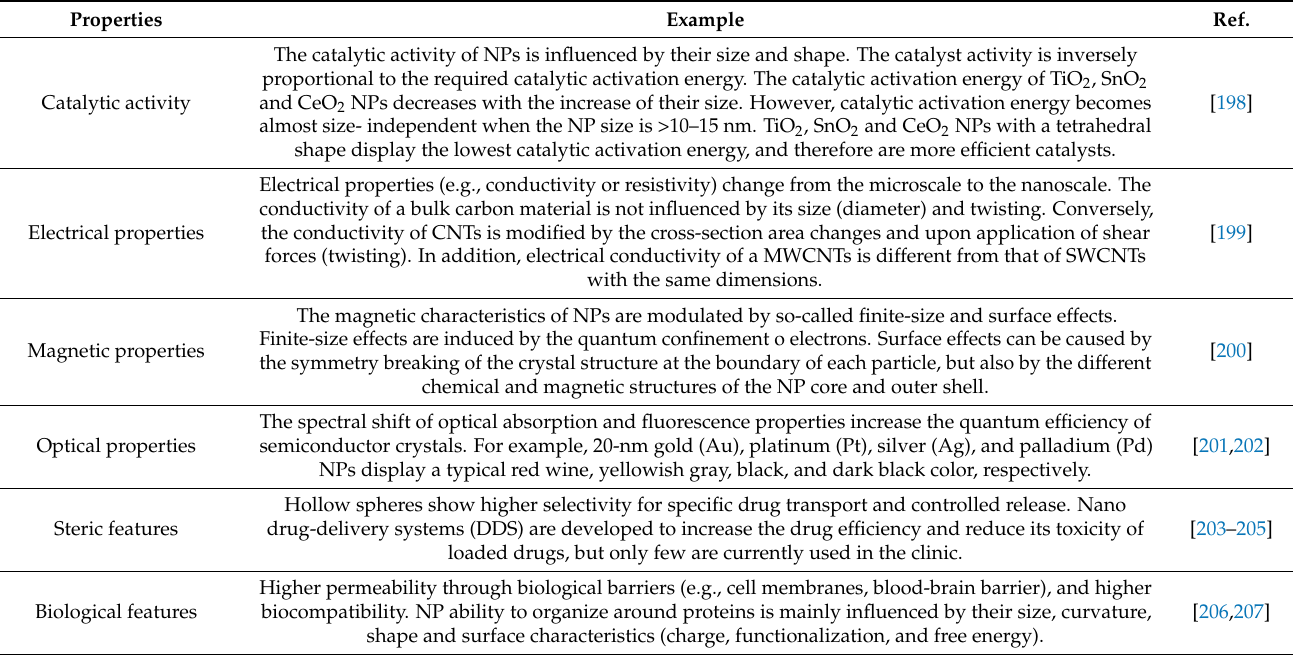
Figure 14. Size- and shape-dependent properties of nanomaterials: ( A – C ) Changes of optical prop- erties (color) [196], © RSC, 2012.; ( D ) Rolling of graphite layer into single-walled and multi-walled carbon nanotubes [130], © Elsevier, 2019; Self-assembly of ( E ) lipids and ( F ) proteins into complex nanostructures [197], © Nature, 2017. Table 3. Adjustable properties of nanomaterials as a function of the synthesis method.